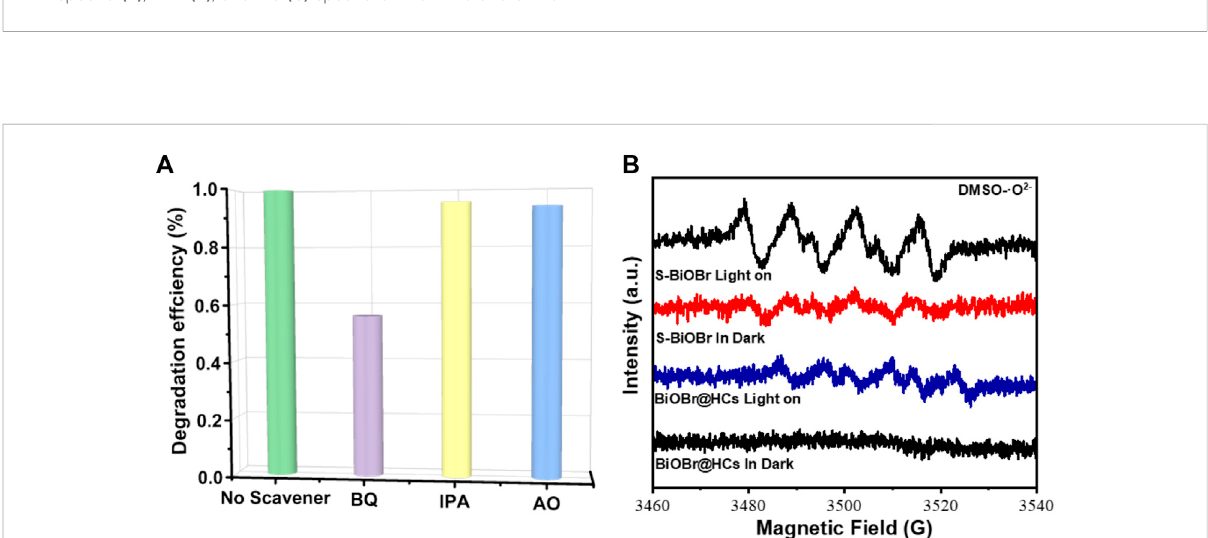
FIGURE 10 Trapping tests for the photodegradaton of TC over SBB-100 (A) and ESR spectra of BiOBr-15 and SBB-100 for the detection of O 2 − (B) under visible-light irradiation for 5 min.